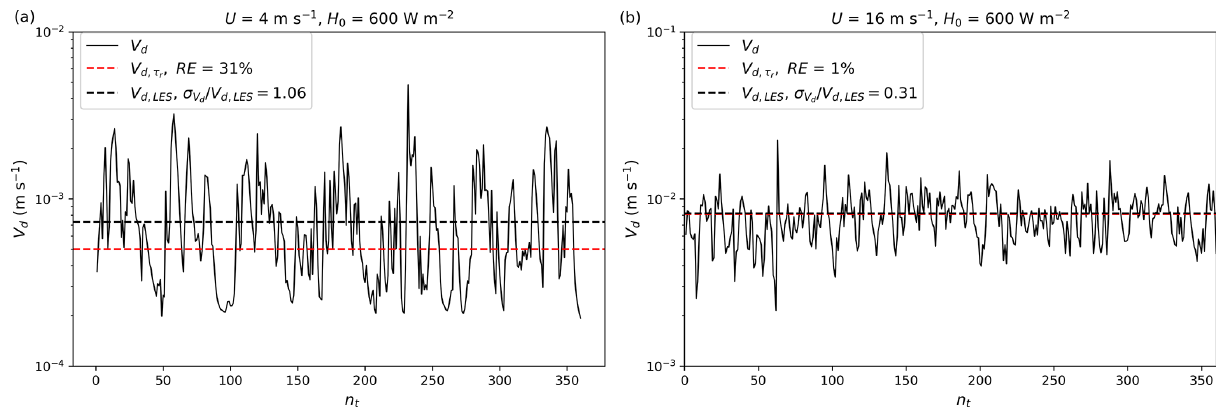
(cid:12) (cid:12) V d , LES − V d ,τ r (cid:12) (cid:12) × 100% is the relative error between V